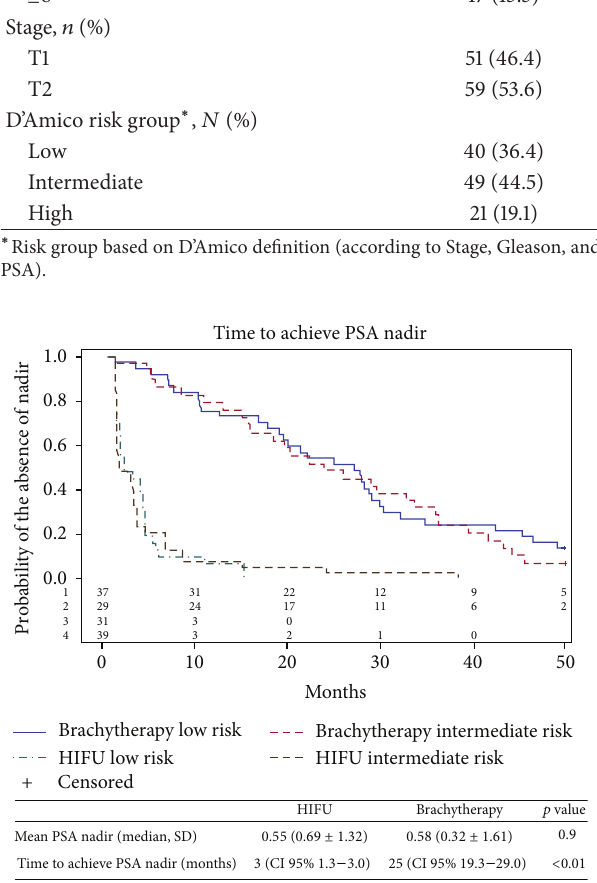
Figure 1: Time to achieve PSA nadir after HIFU and brachytherapy according to the classification of